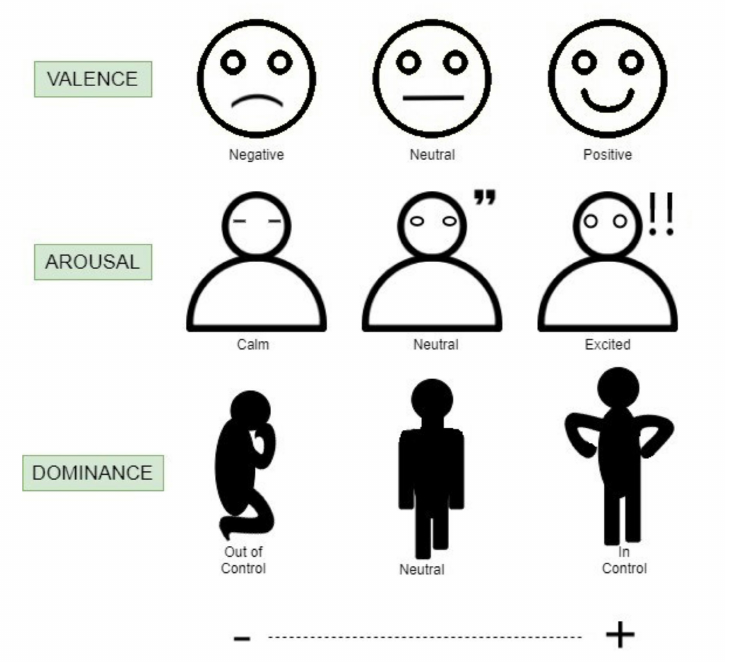
Figure 5. The graphical scheme provided to subjects to understand the ADM scales